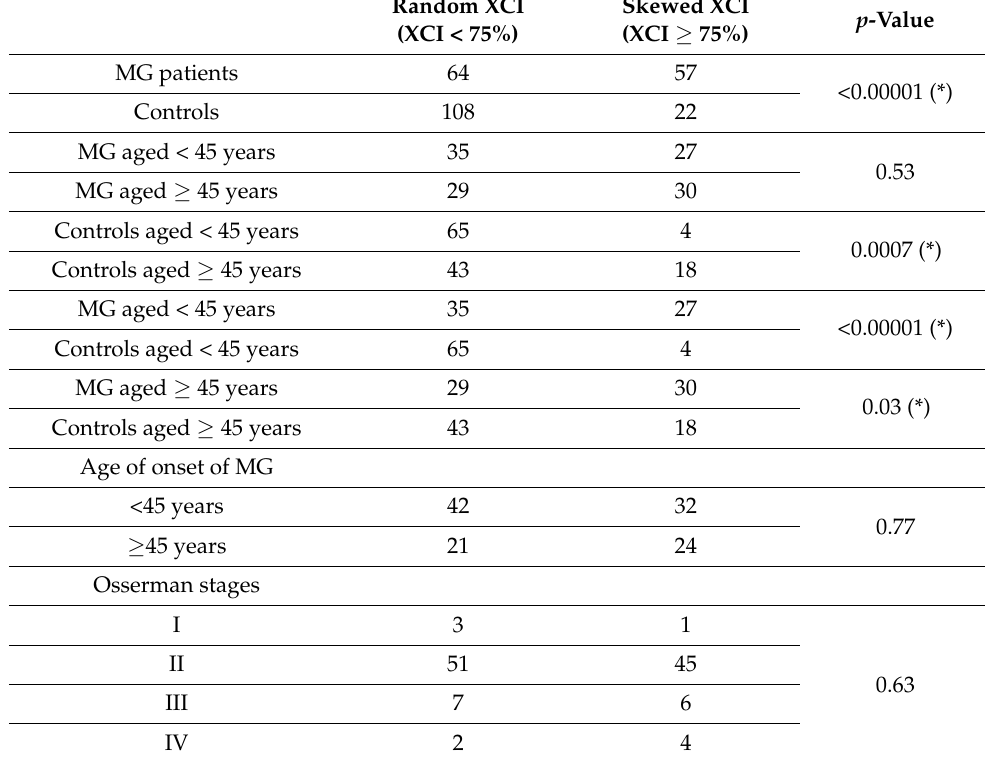
Table 3. Distribution of XCI pattern in patients and controls (“MG/Control aged” is referred to age at blood collection). The chi-squared test and Fisher’s exact test were used, and the Yates’s correction was applied to the p -values obtained. Statistically significant results are marked with (*). Random XCI (XCI <